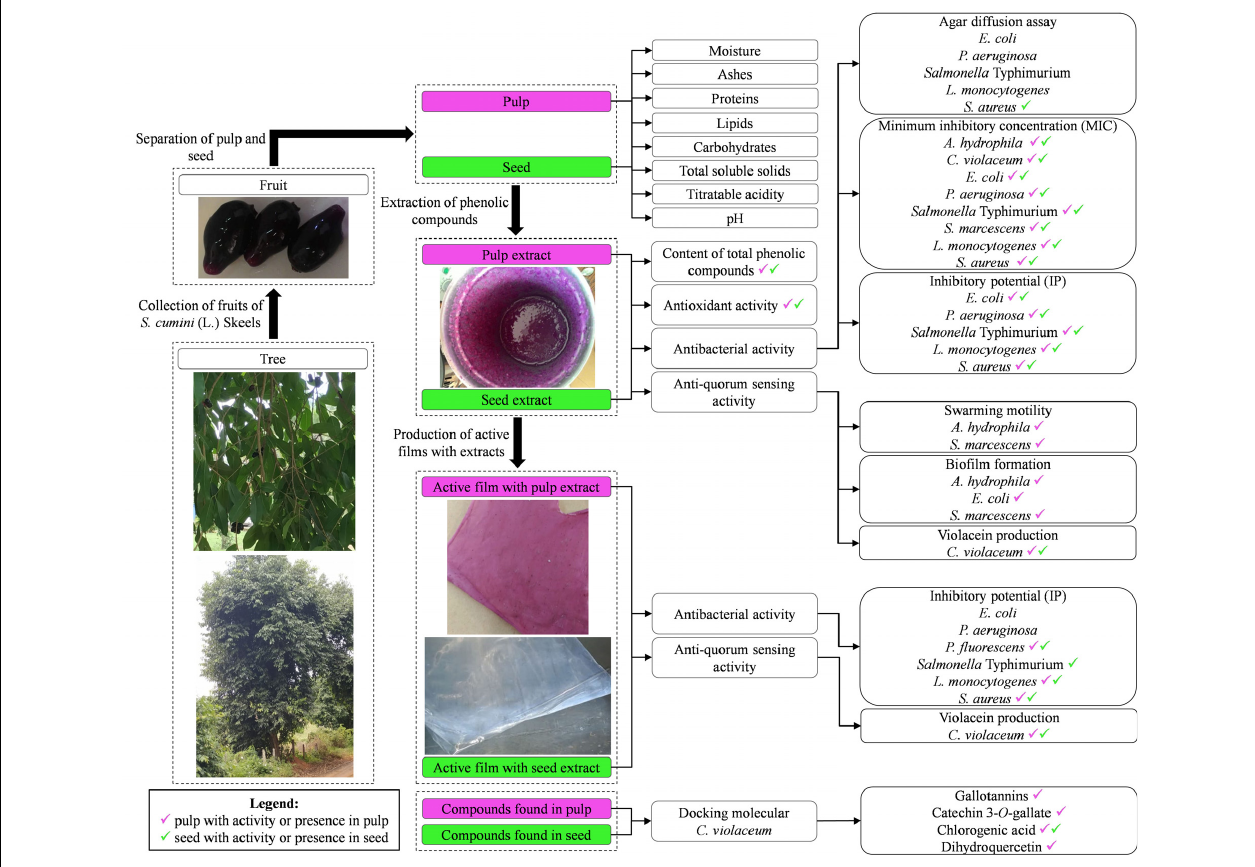
FIGURE 6 | Experimental design used in this study with the main